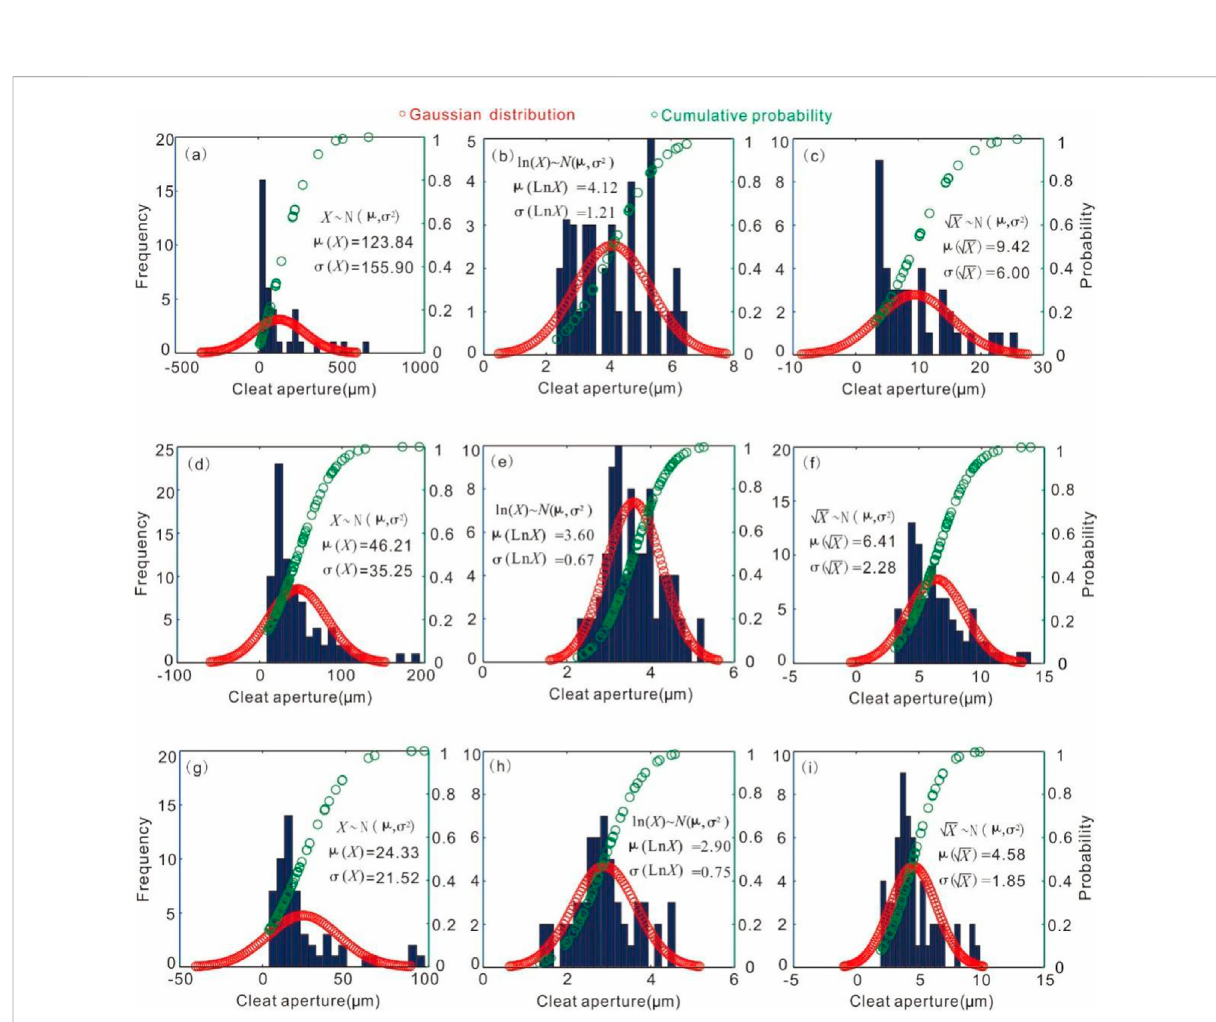
FIGURE 10 Cleat aperture distribution for the coals with different ranks: (A – C) , low-ranking coal; (D – F) , middle-ranking coal; (G – I) , high-ranking coal.